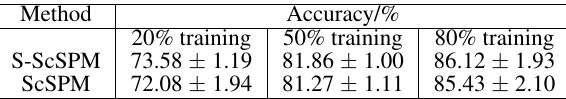
Table 1. Overall classification accuracy on UC Merced data set